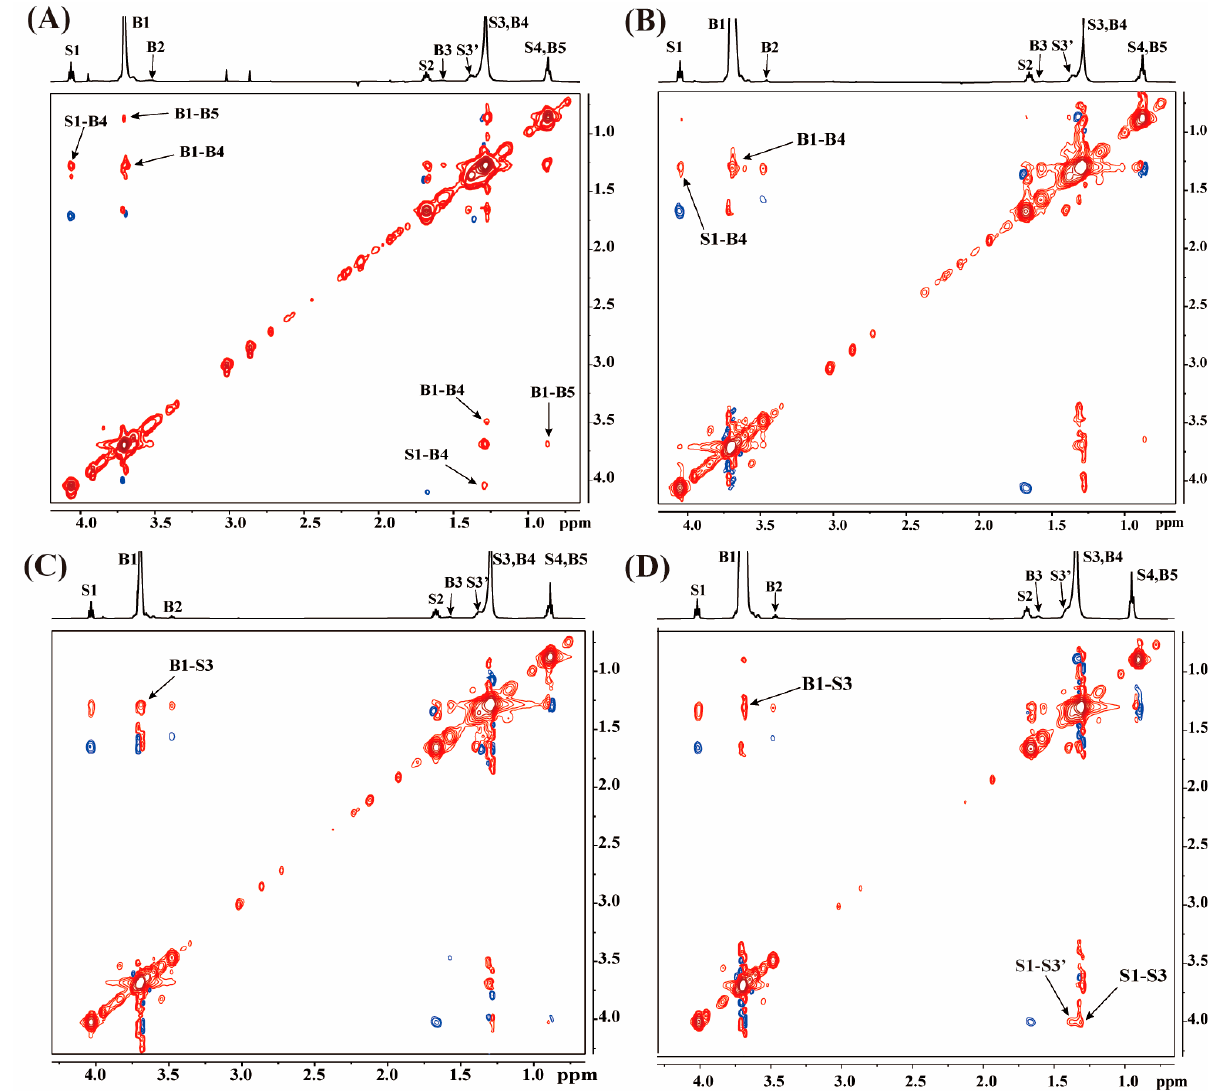
Figure 6. NOESY spectra with a mixing time of 0.5 s for α SDS = 0.8 at C T of 0.50 ( A ), 2.0 ( B ), 5.0 ( C ) and 40 mM ( D ), respectively.